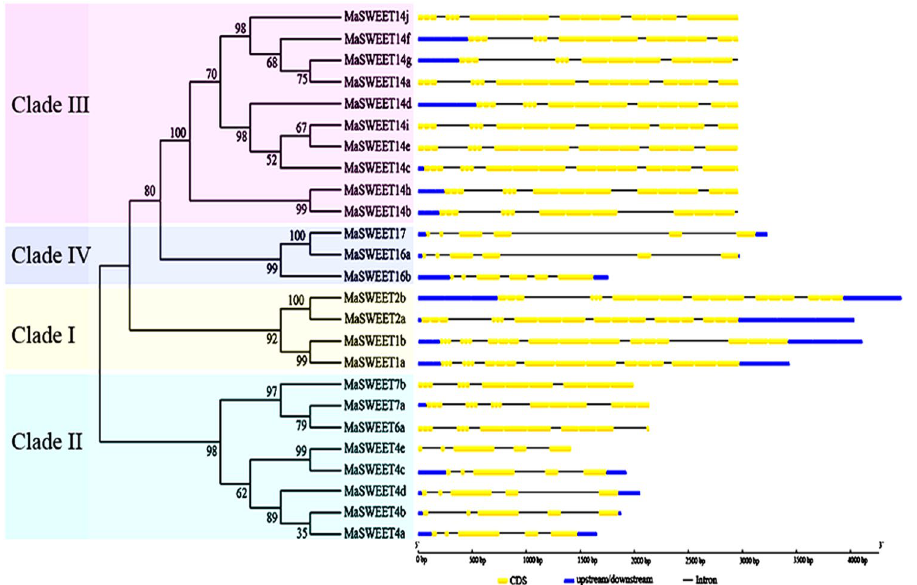
Figure 2. Gene structure analyses of MaSWEETs . Exon-intron structure analyses were performed using the Gene Structure Display Server database. Blue boxes indicate upstream/downstream; yellow boxes indicate exons; black lines indicate